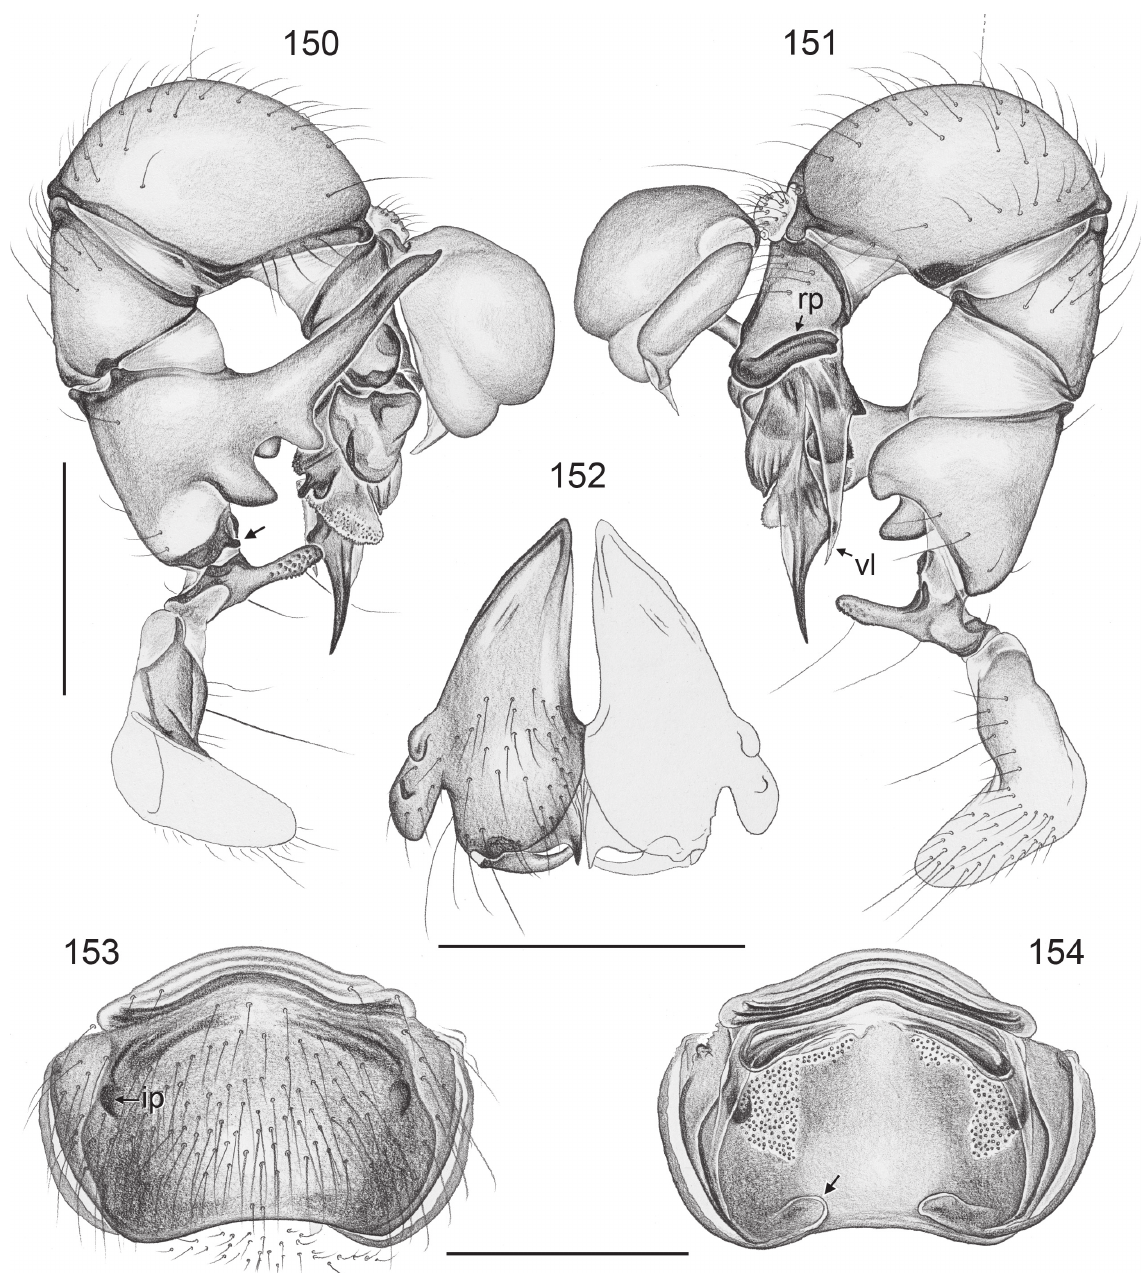
Figs 150–154. Aetana indah Huber, sp. nov. 150–151 . Left male palp, prolateral and retrolateral views (arrow points at prolateral apophysis near hinge). 152 . Male chelicerae, frontal view. 153–154 . Cleared female genitalia, ventral and dorsal views (arrow points at membranous pocket). ip = internal sclerotized pocket; rp = retrolatero-ventral process; vl = ventral lamina. Scale lines: 0.5